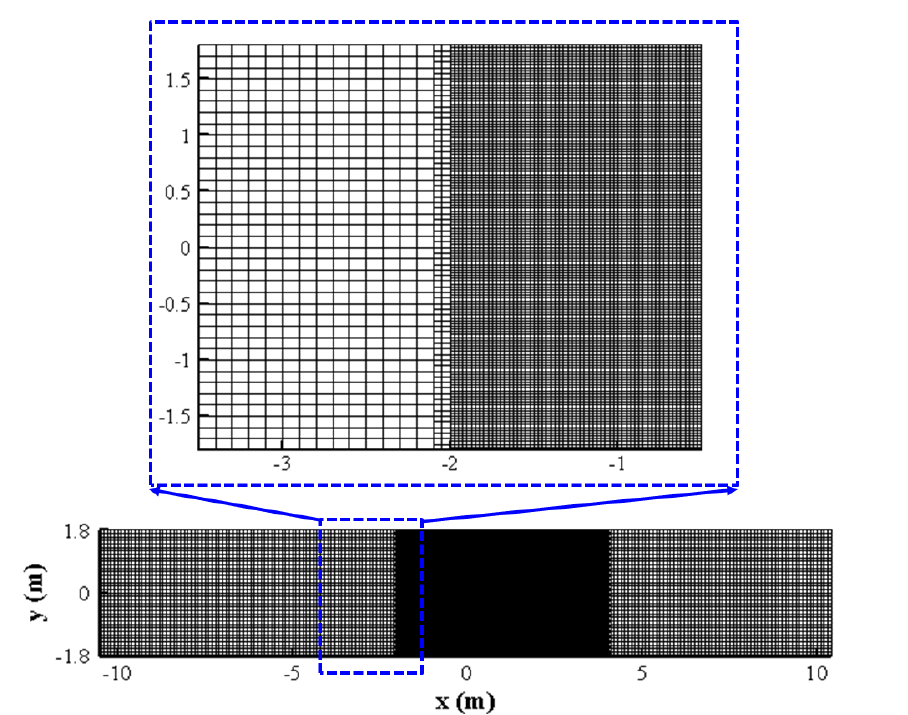
Figure 14. The computational grid for the partial dam-break flow over mobile